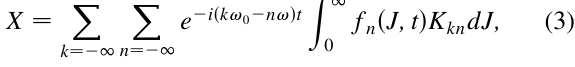
vertical ones at the zero crossing of C